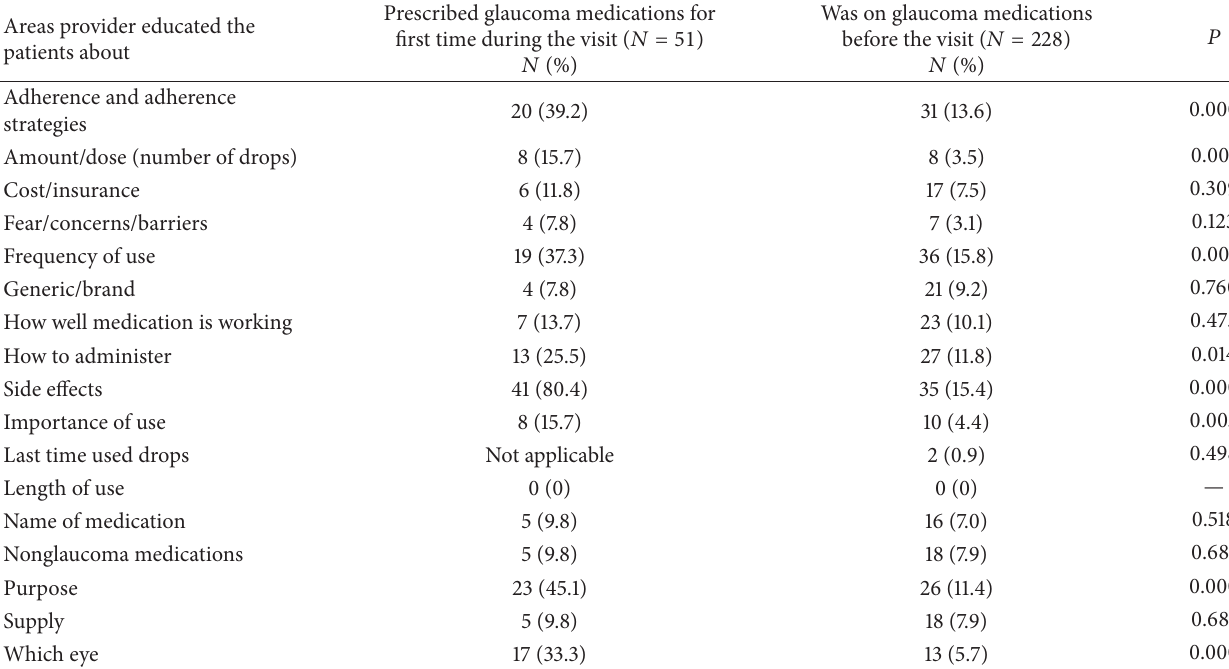
Table 2: Provider educates the patients about glaucoma medications by whether patients are prescribed glaucoma medications for the first time or if they were on them before the visit ( 𝑁 = 279 ).